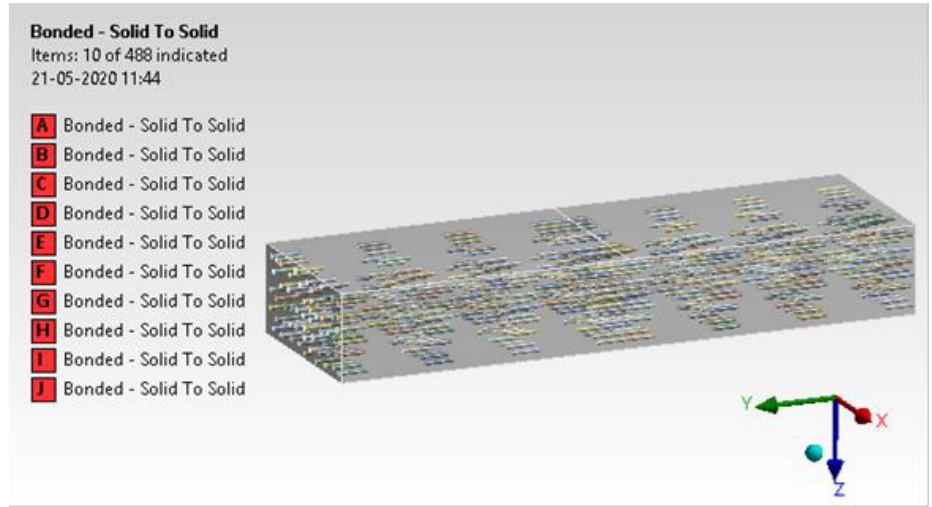
Figure 12. Contact generation.